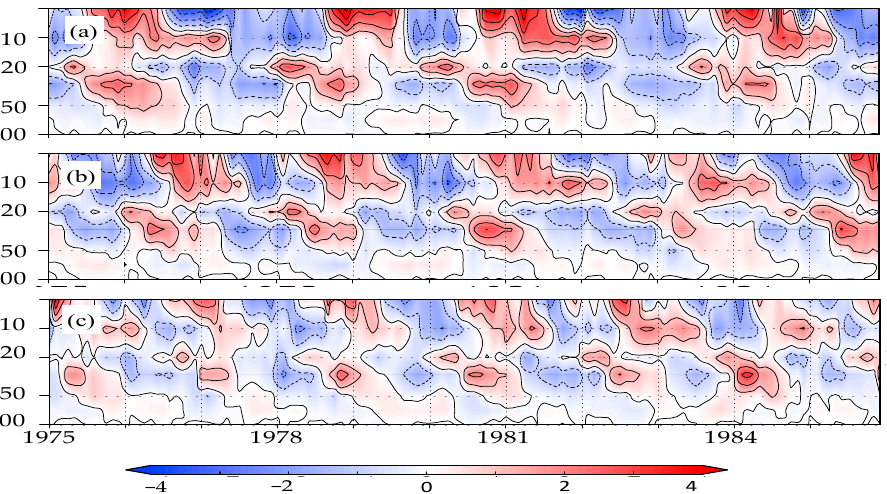
Figure 6. Time–height cross-sections of zonal–mean solar heating anomalies averaged between 10 ◦ S and 10 ◦ N in the tropical stratosphere for the ( a ) P, ( b ) ST, and ( c ) N runs from 1975 to 1985. Units of the color bar scale are in K mon − 1 , and the contours interval is 1 K mon − 1 .